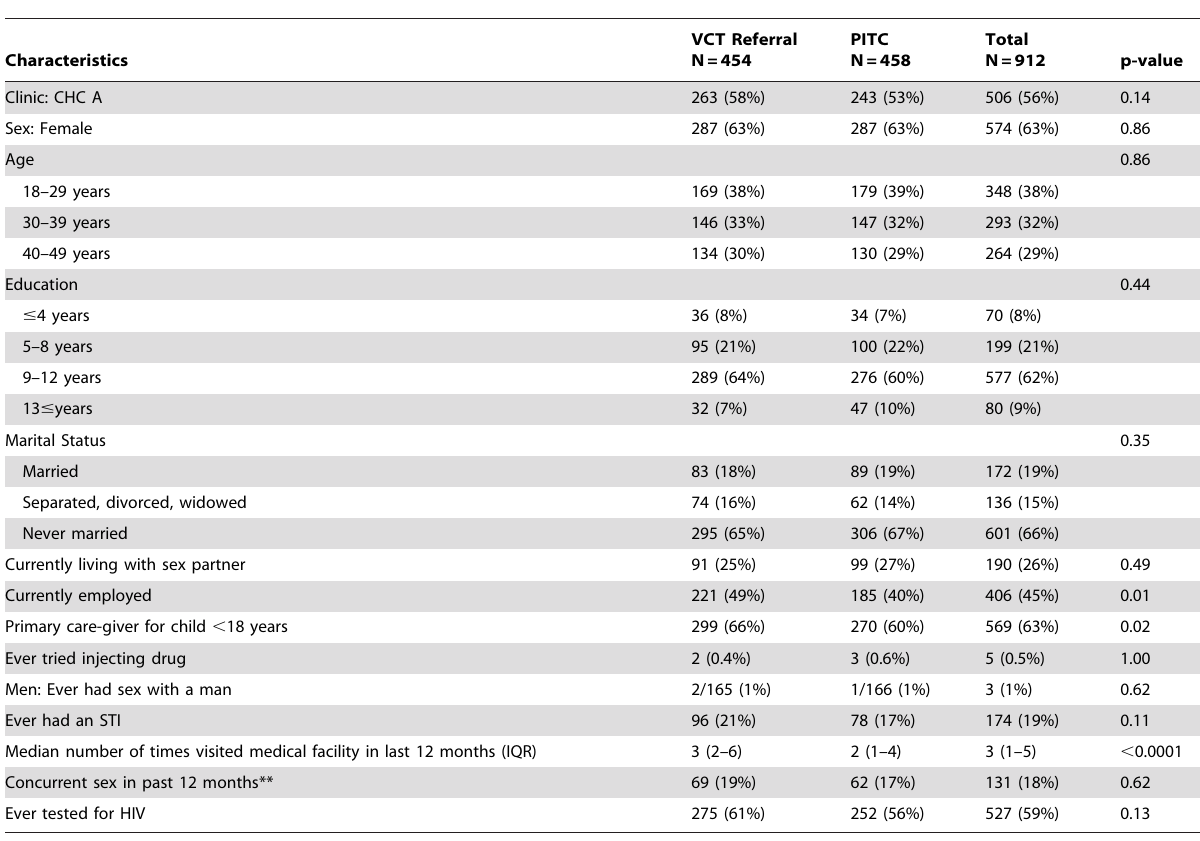
Table 1. Study participant characteristics by HIV testing